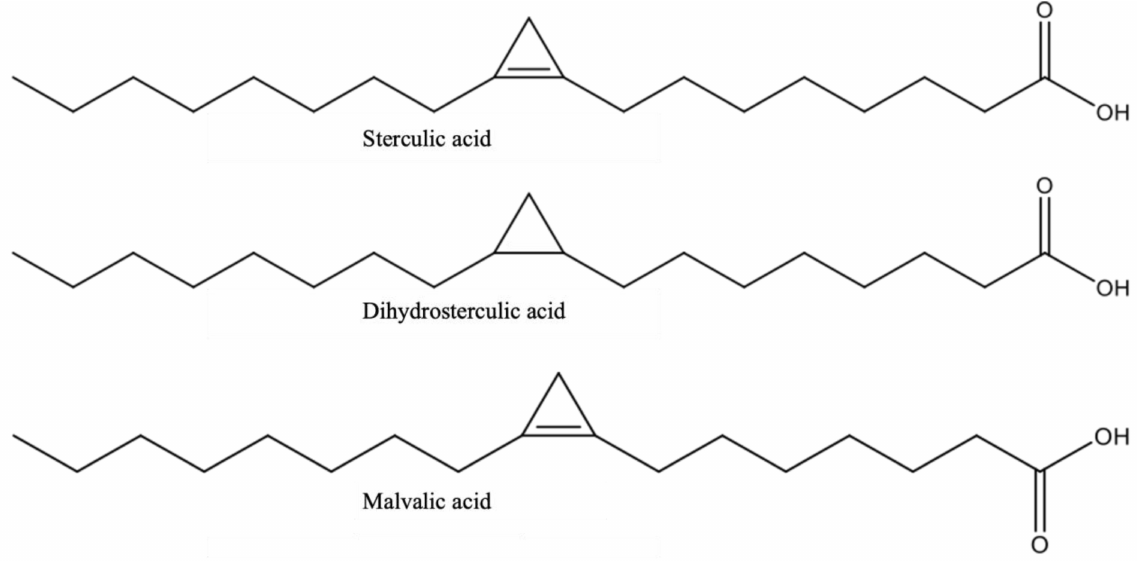
Figure 3. Chemical structures of sterculic, dihydrosterculic and malvalic acids.